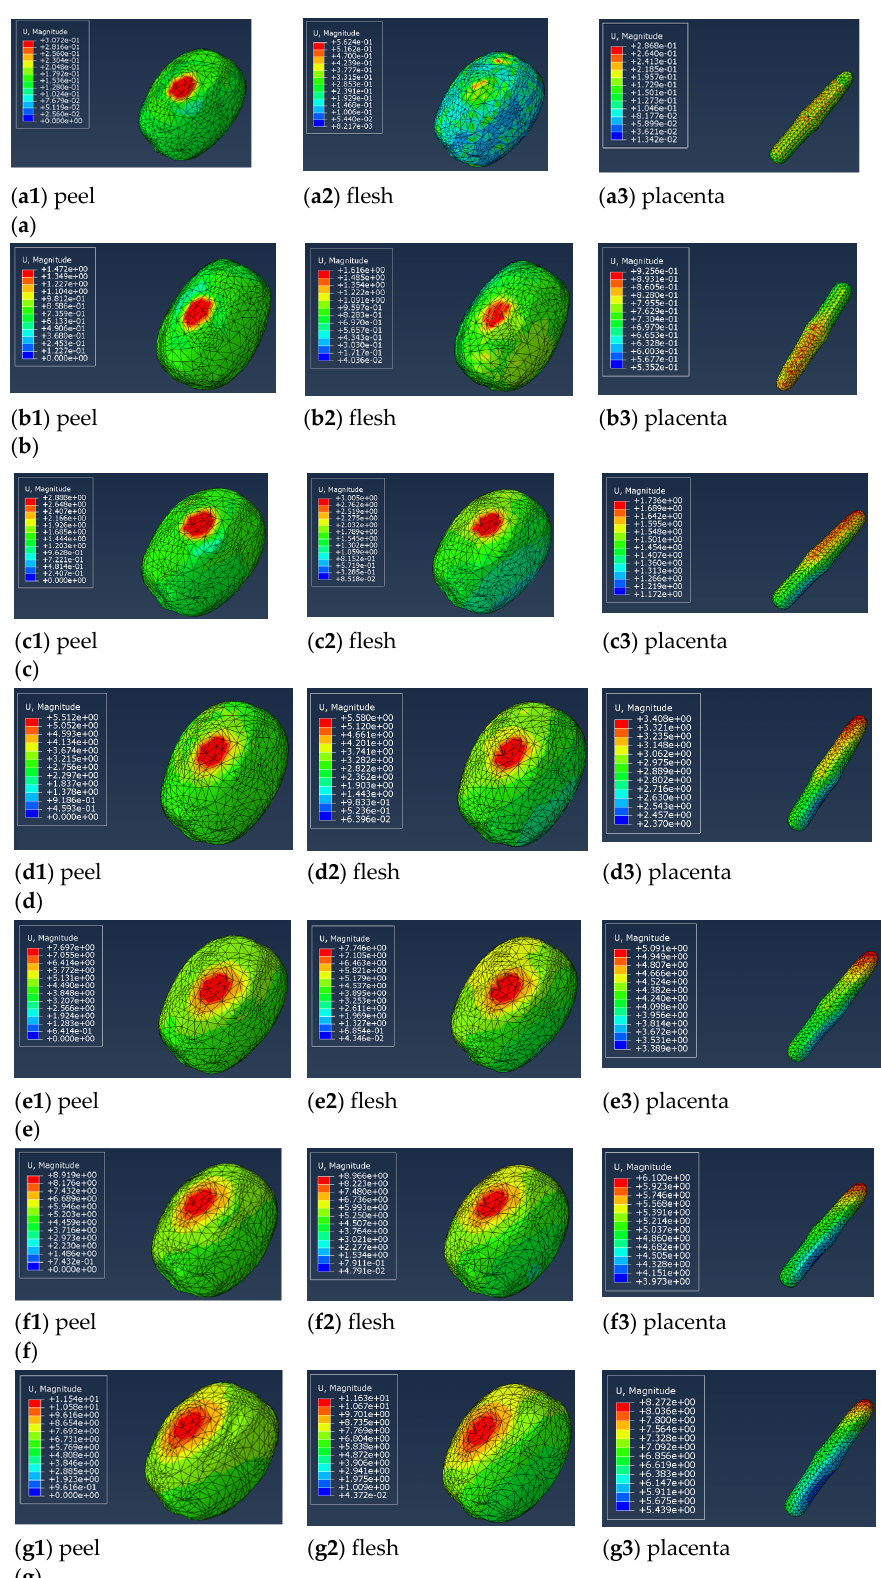
Figure 5. Kiwifruit deformation diagram under different forces. ( a ) 5 N Stressed; ( b ) 25 N Stressed; ( c ) 50 N Stressed; ( d ) 100 N Stressed; ( e ) 150 N Stressed; ( f ) 180 N Stressed; ( g ) 250 N Stressed. It can be seen from Figure 5 that the compression set of each part of the kiwifruit gradually increased with the increase in force. At the same time, it can be seen from the figure that the force of kiwifruit was proportional to the strain. At 5 N, the kiwifruit was in the elastic stage, and the flesh and placental strain were much smaller than the peel. With the continuous increase in force, the maximum strain of the peel and its distribution range continued to expand, but the strain and strain range of the flesh part were wider than the deformation range of the peel under the same force. In Figure 6, the model sim- ulates the damage state, and the bruises in the actual test are similar. Especially in the stress state of 180 N, the damaged part of kiwifruit spreads to other parts with the force point. The kiwifruit strain cloud was consistent with the test results. At the same time, the increase in force magnitude made the area of the maximum strain distribution of the ki- wifruit flesh move towards the inside of the flesh. The stress situation could also be